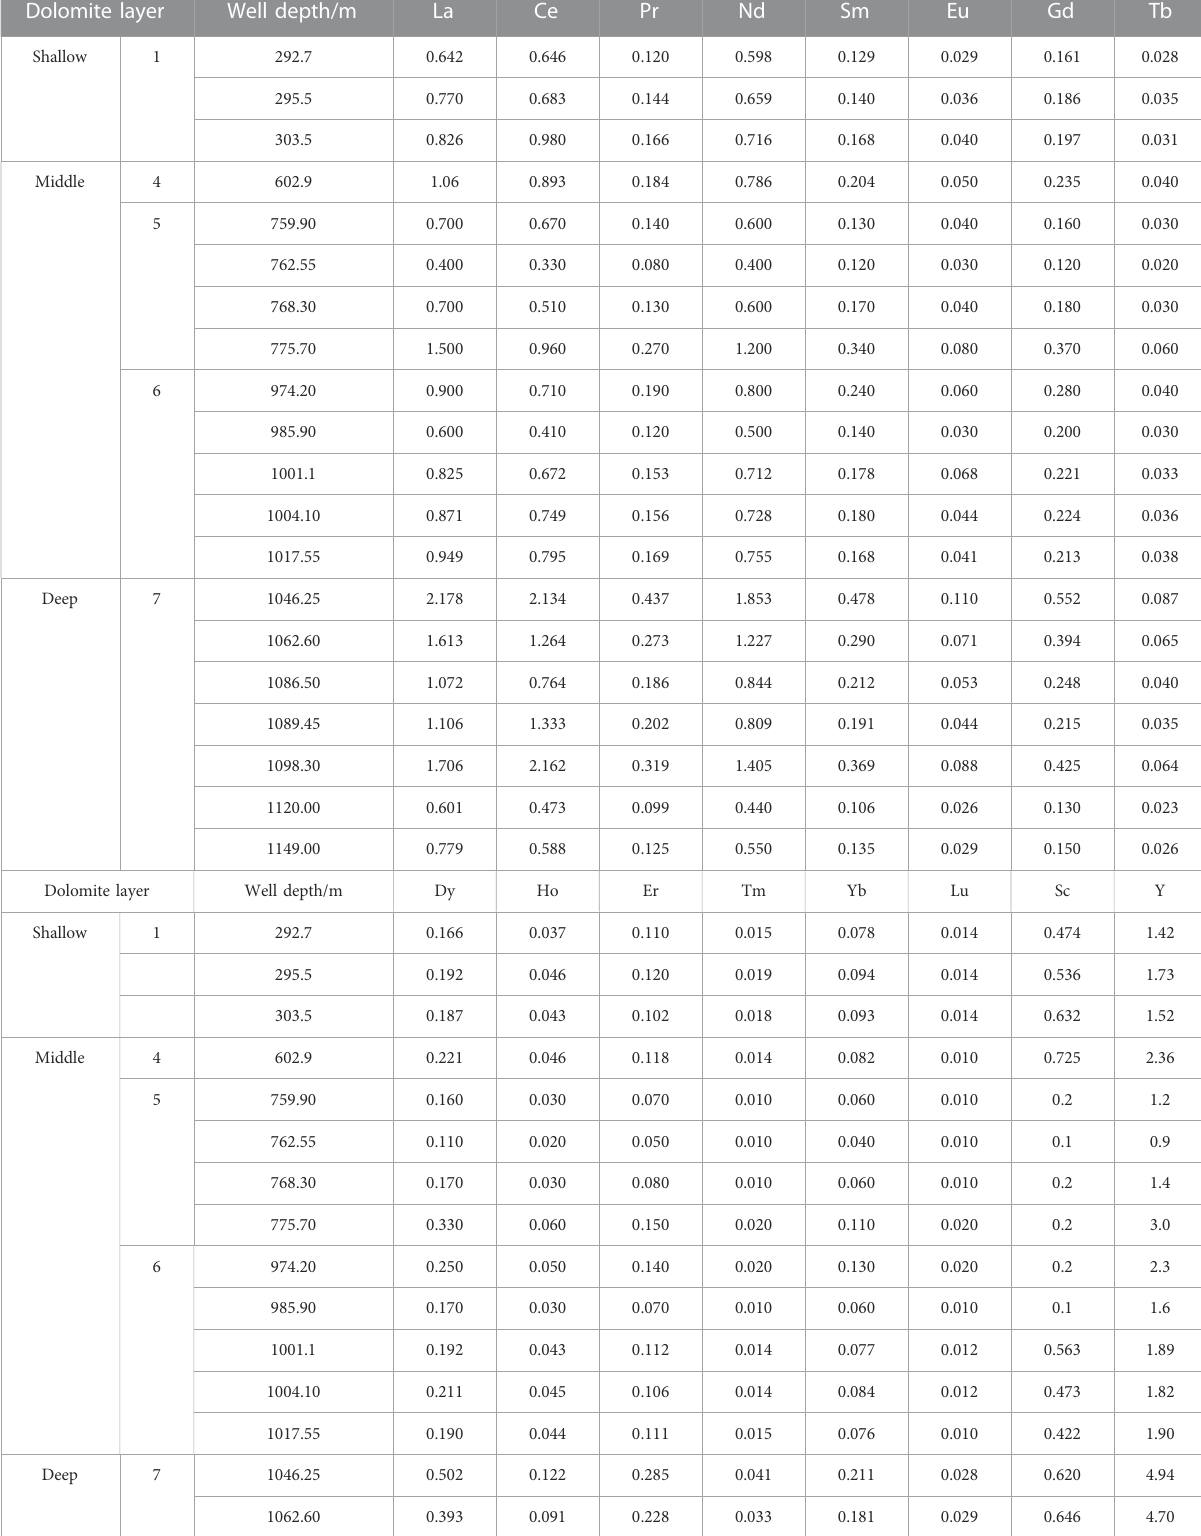
TABLE 4 Rare earth element parameters of shallow, middle and deep dolomites (ug/g). Dolomite layer Shallow